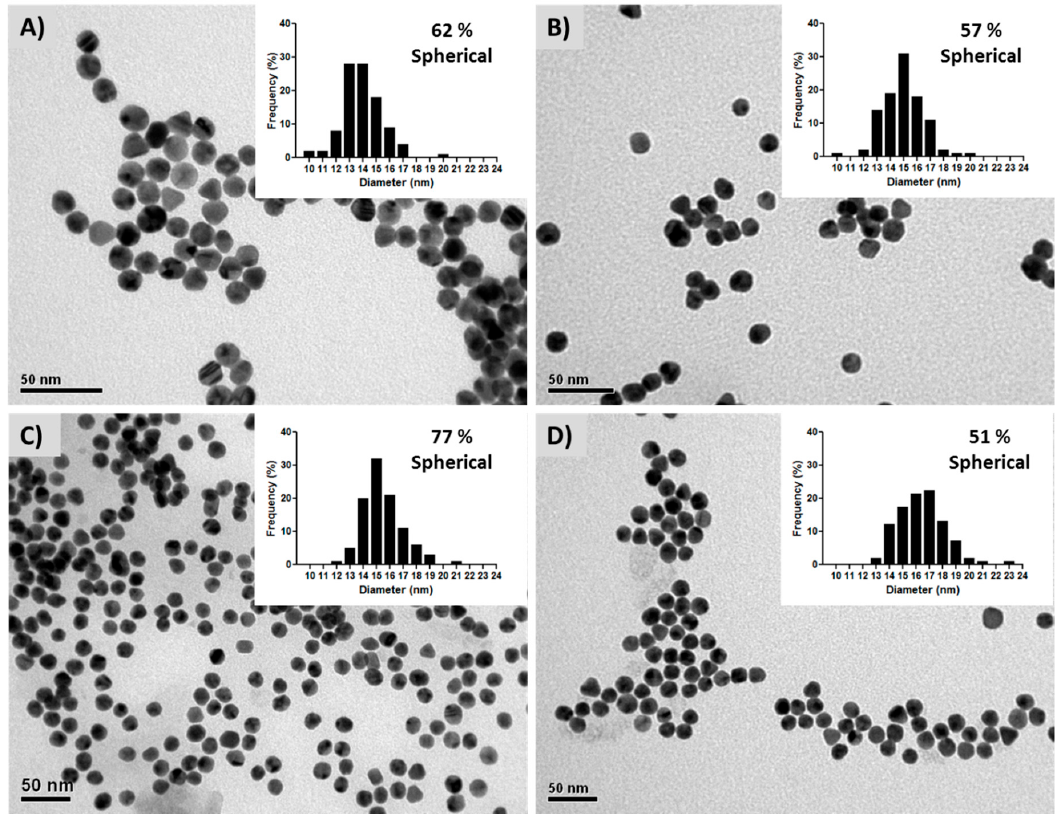
Figure 3. Transmission electron microphotographs of AuNPs at pH 4.7 ( A ), 5.0 ( B ), and 5.3 ( C ), and commercial AuNPs (pH 5.0) with an average diameter of 16.42 ± 1.76 nm ( D ). Histograms with the respective particle size distributions and the percentage of spherical nanoparticles are included as insets within each microphotography.